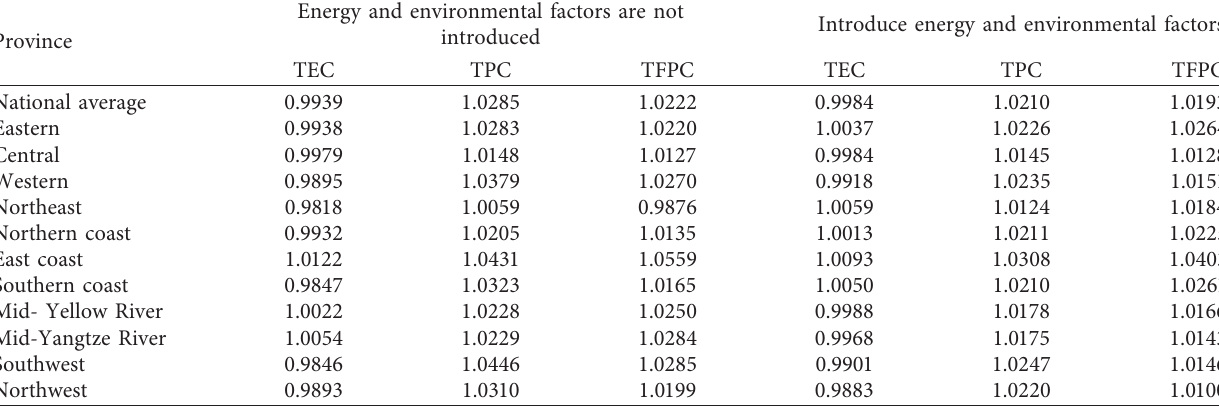
Table 4: Mean of national and regional TFP index and its decomposition terms (2003–2017).